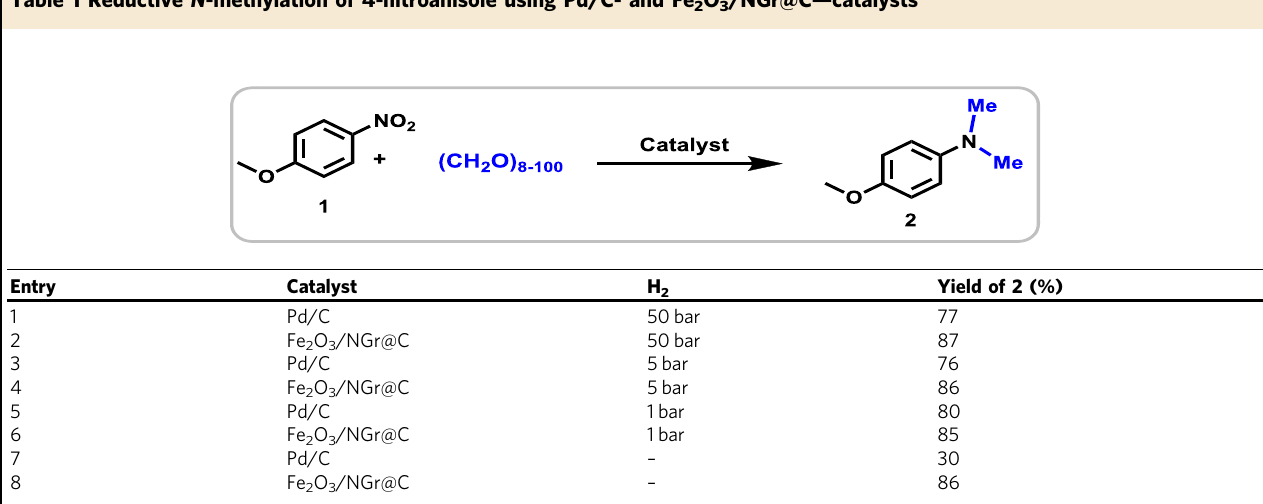
Table 1 Reductive N -methylation of 4-nitroanisole using Pd/C- and Fe 2 O 3 /NGr@C — catalysts a